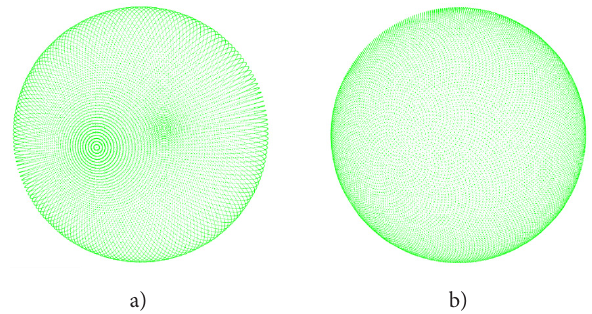
Figure 1. The difference between view representation as: a – square shape flattened on the sphere; b – spherical shape From Figure 1 can be seen, that the distance between the points will never be equal if the mathematical shape of the view is considered as a plane geometry such as in the viewshed method. Multiple points that have the same position on the sphere surface (illustrated in Figure 1a) represent the corners of the square. On the other side, the spherical representation of the view consists of the points that have equal distance between each other. Such a uni- form scatter of the points shows that the calculations are valid not only for the part of the view but also for the entire mathematical shape.